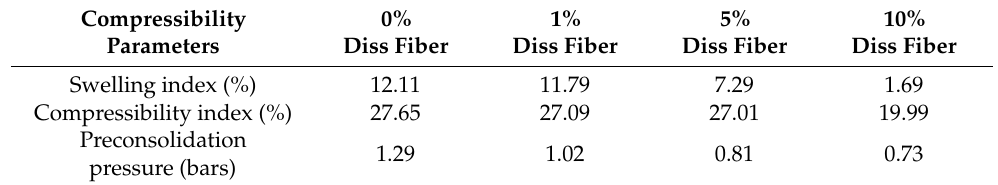
Table 5. Variation of compressibility parameters as a function of the percentage of Diss